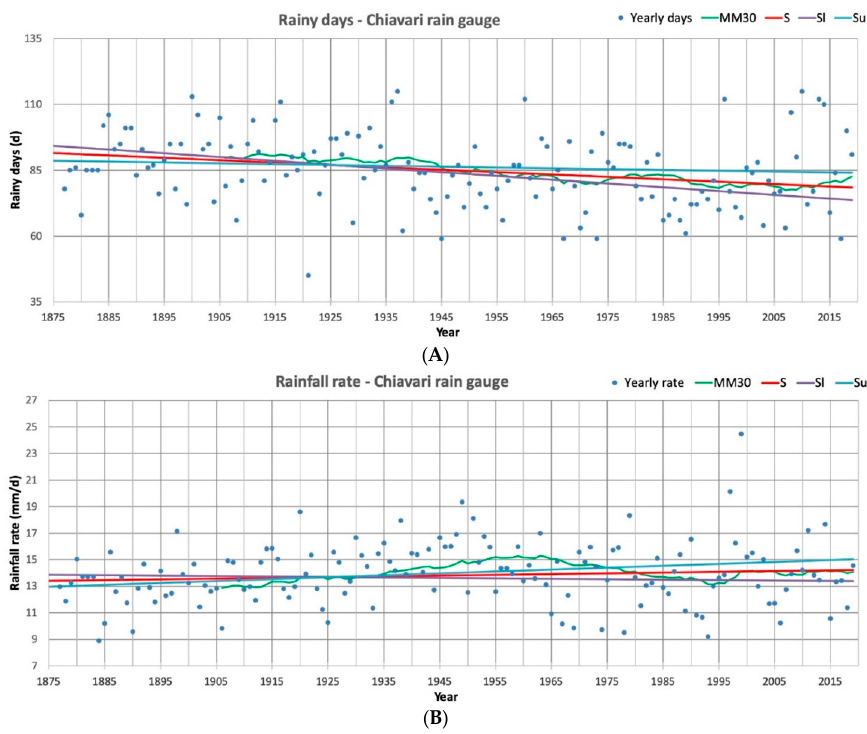
Figure 12. Rainy days ( A ) and rainfall rate ( B ) series scatterplot for Chiavari rain gauge (1877–2019); MM30: mean mobile at 30 years; S: Sen’s trend line; Sl: Sen’s lower confidence (95%) slope; Su: Sen’s upper confidence (95%) slope .